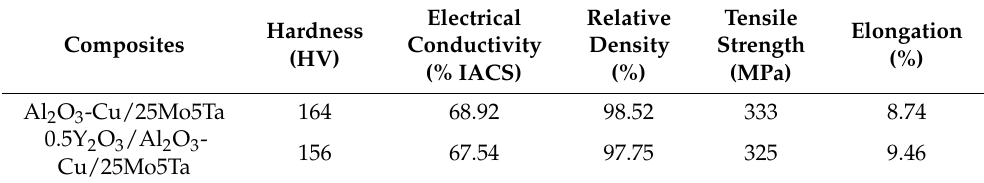
Table 2. Comprehensive performance of composite